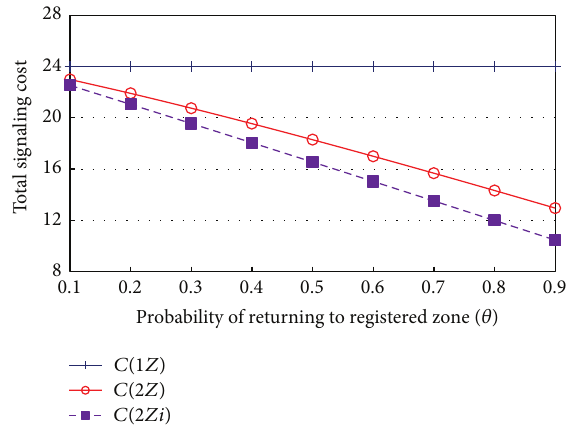
Figure 5: Signaling cost with respect to 𝜃